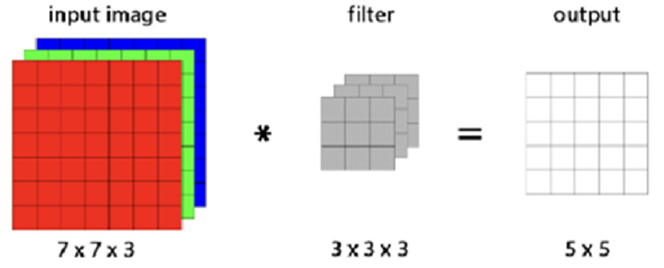
Figure 8. CNN for RGB images.